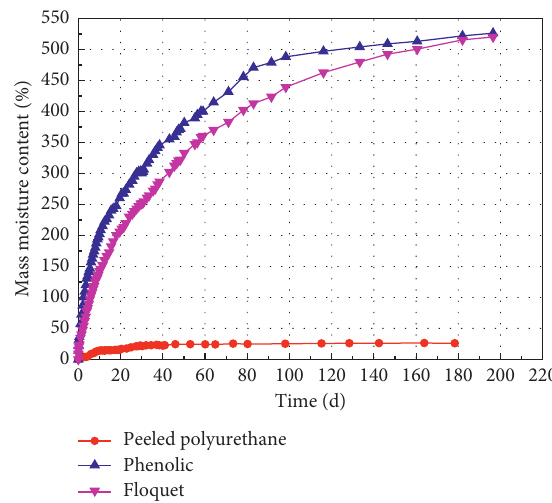
Figure 7: Curve of the water content of the thermal insulation material with time after natural active water absorption.